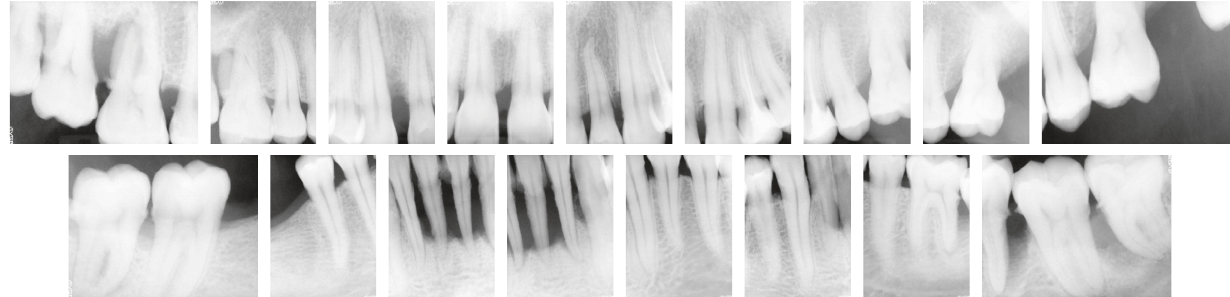
Figure 2: Full mouth periapical X-rays showing severe bone loss at lower anterior sextant and vertical bone loss at 13 and